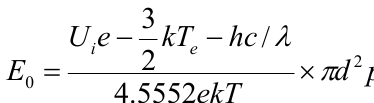
) and the proportion of mixed gas molecule number 0